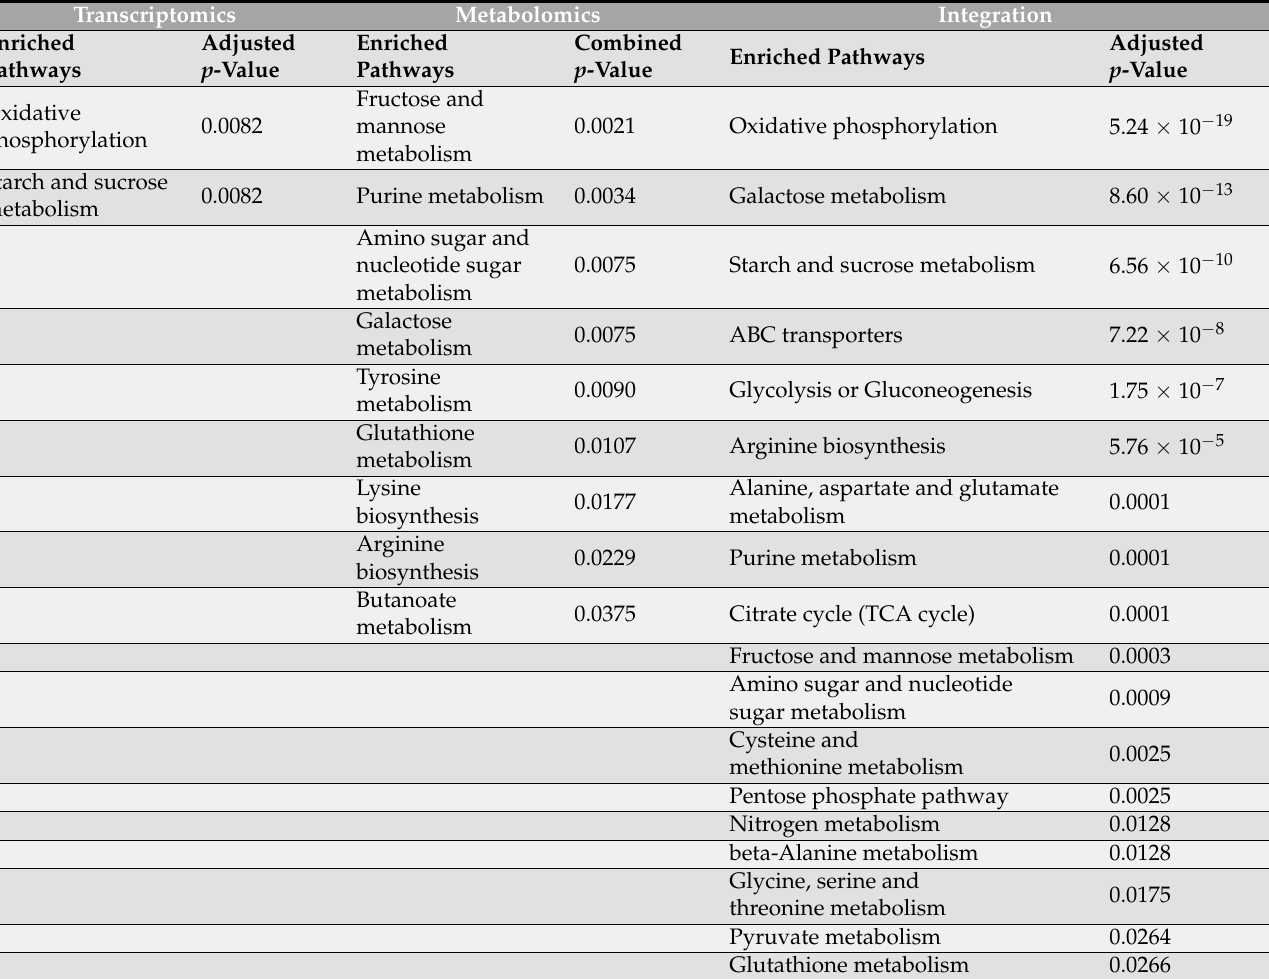
Table 1. Single- and multi-omics integration results for gpr1 ∆ . The first block shows GSEA for transcriptomics with adjusted p -value < 0.05, arranged in ascending order; second block shows MetaboAnalystR pathway enrichment analysis for metabolomics with combined p -value < 0.05, arranged in ascending order; third block shows MetaboAnalystR joint pathway analysis with adjusted p -value < 0.05, arranged in ascending order, as detailed in the